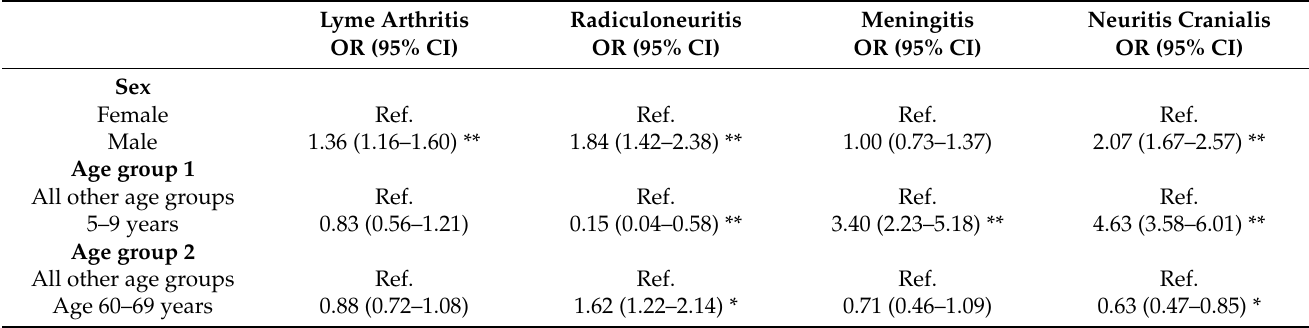
Table 2. Association of age and sex with clinical manifestations among LB cases ( n = 35,458) reported from 2013 to 2020 in Bavaria, Germany: Results of univariate logistic regression analysis.